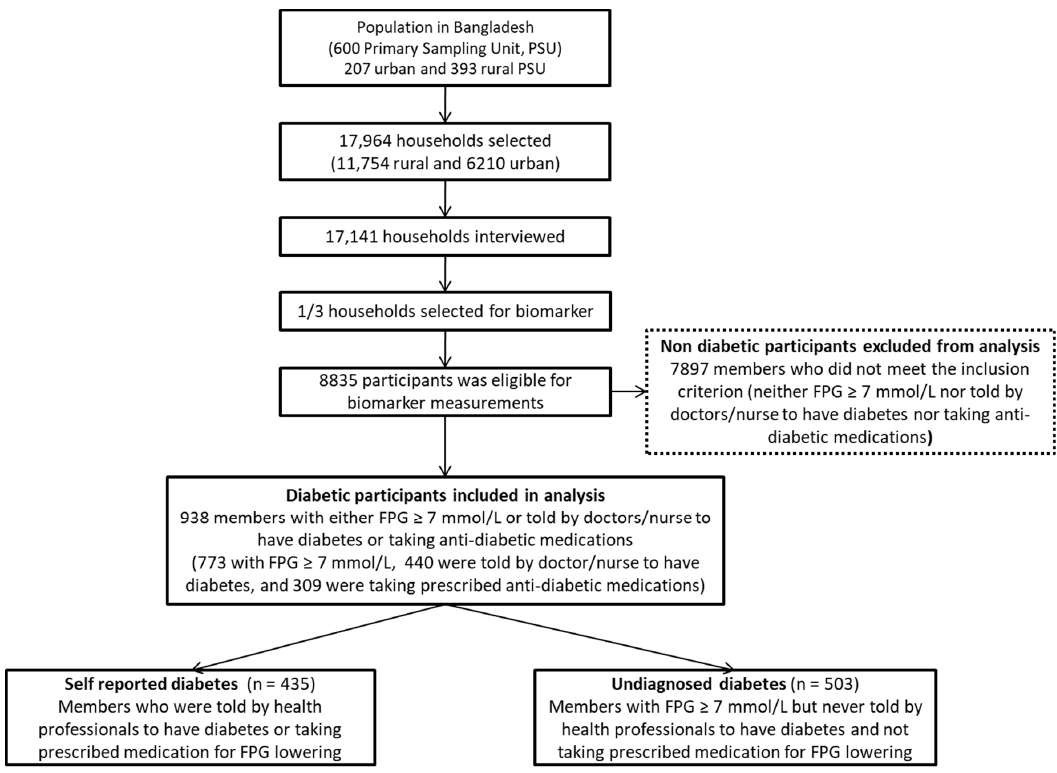
Figure 1. Selection of participants for this study. FPG = fasting plasma glucose.